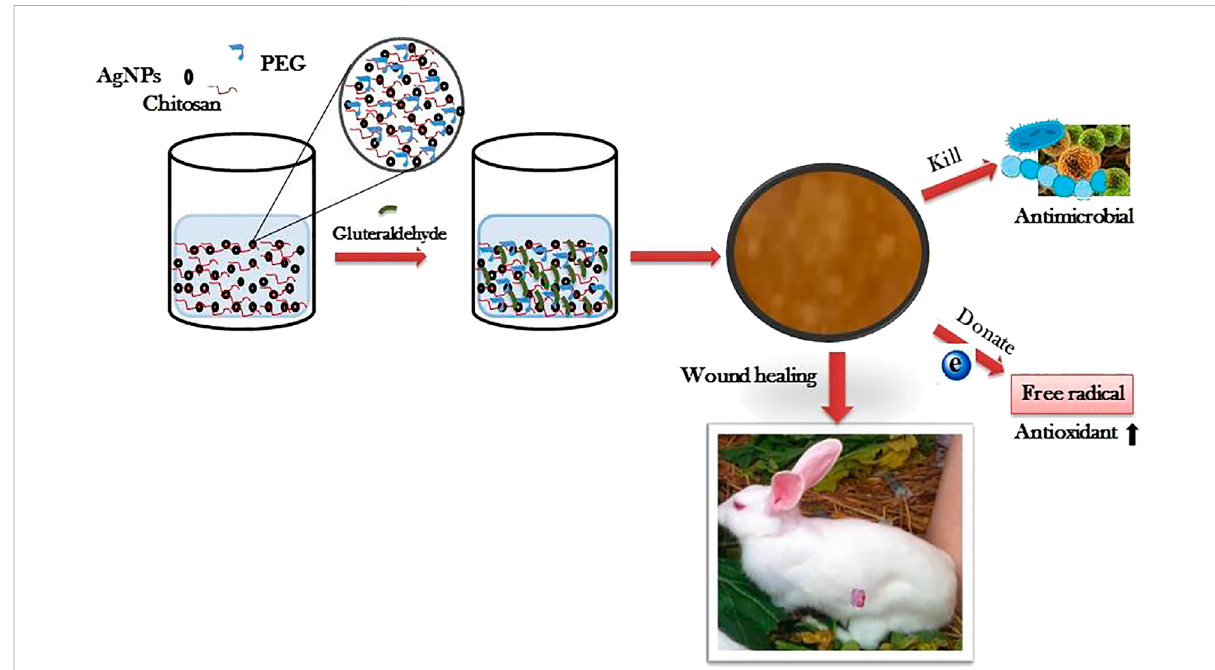
FIGURE 5 The preparation process of Silver nanoparticle impregnated chitosan-PEG hydrogel and its therapeutic effect on diabetic rabbit wounds. Reproduced from (Masood et al., 2019), with permission from Elsevier.